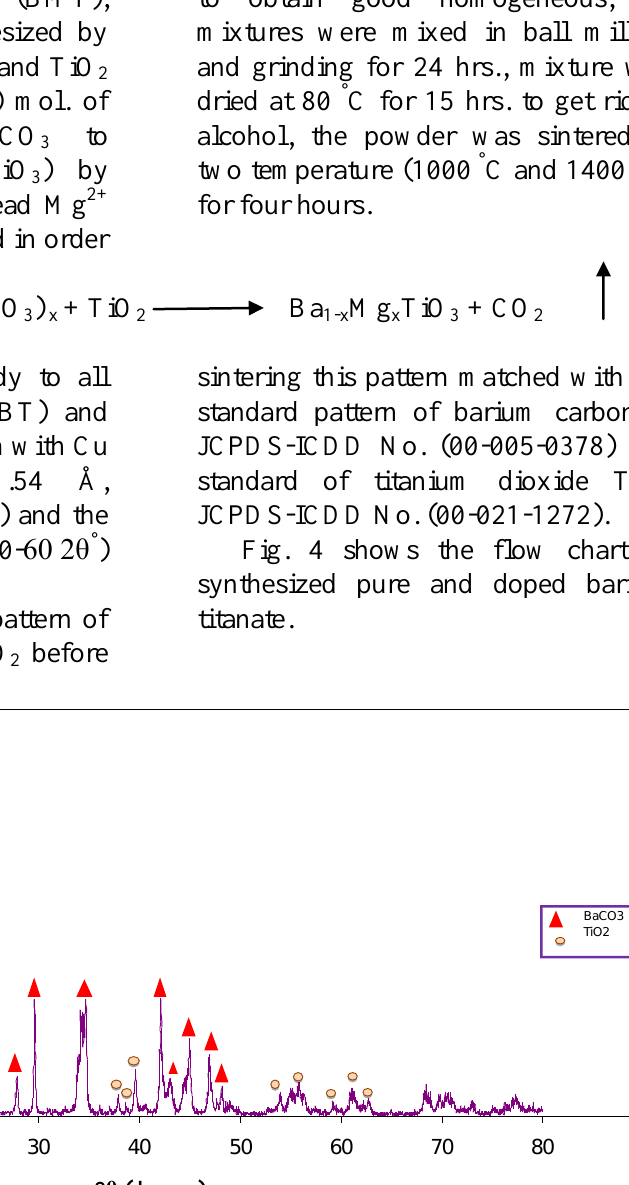
and Titanium oxide TiO